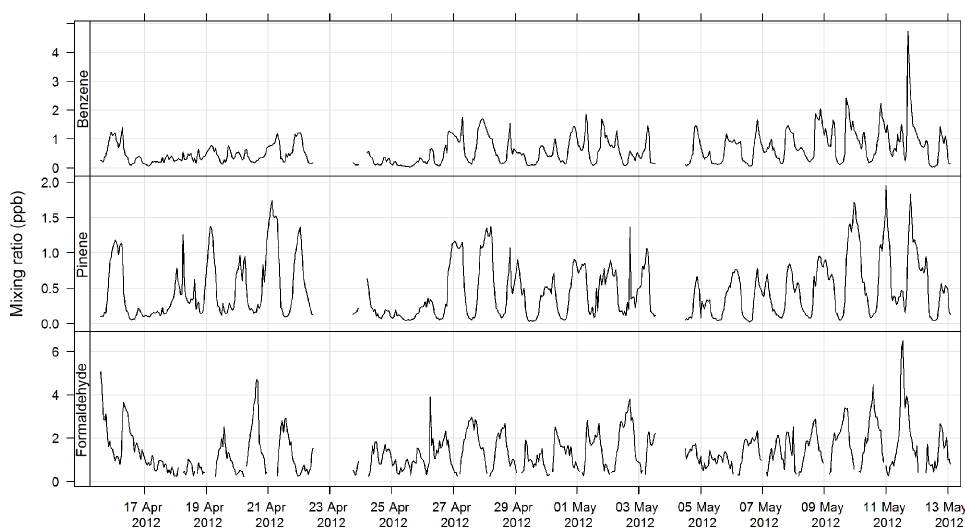
Figure 5. Time series of ambient benzene, α -pinene, and formaldehyde mixing ratios during SPS-II measured with the PTR-MS instrument.